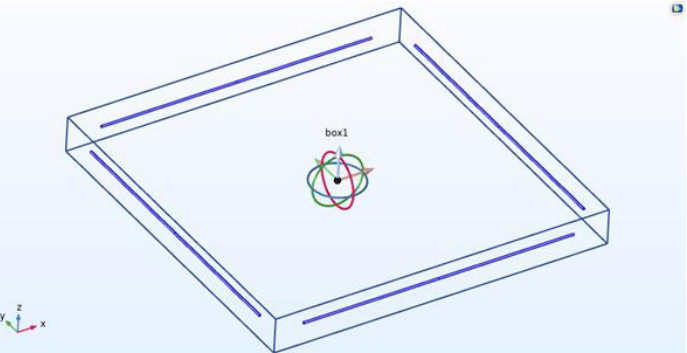
Figure 6. Structure of CP MD antenna array.